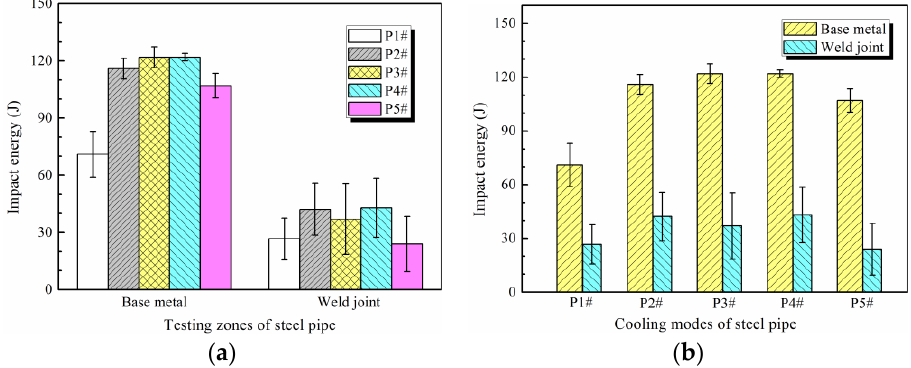
Figure 7. Impact energy of steel pipes: ( a ) comparison of different processes; and ( b ) comparison of different zones.